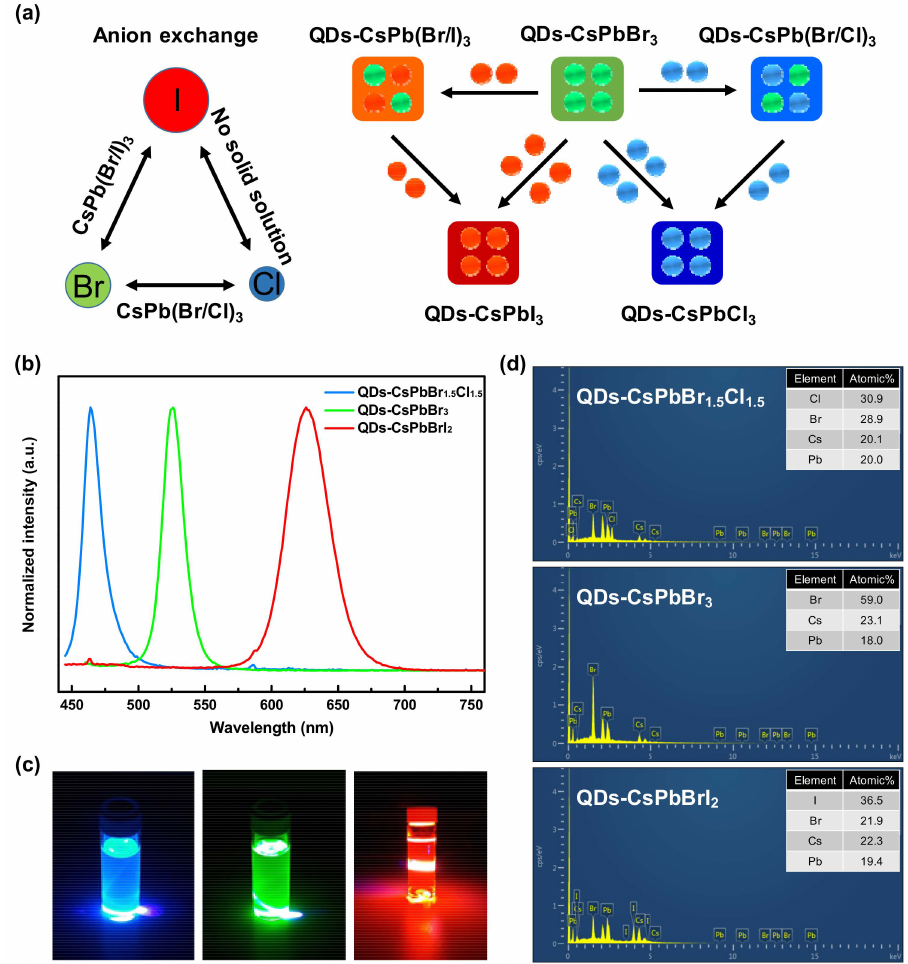
Figure 4. ( a ) Schematic of the anion exchange between the QDs-CsPbX 3 ; ( b ) photoluminescence (PL) emission spectra of QDs-CsPbX 3 solutions; ( c ) the emission photographs of the QDs-CsPbX 3 solutions under UV-405 nm laser excitation; ( d ) energy dispersive X-ray (EDX) analysis for the purified QDs-CsPbX 3 .